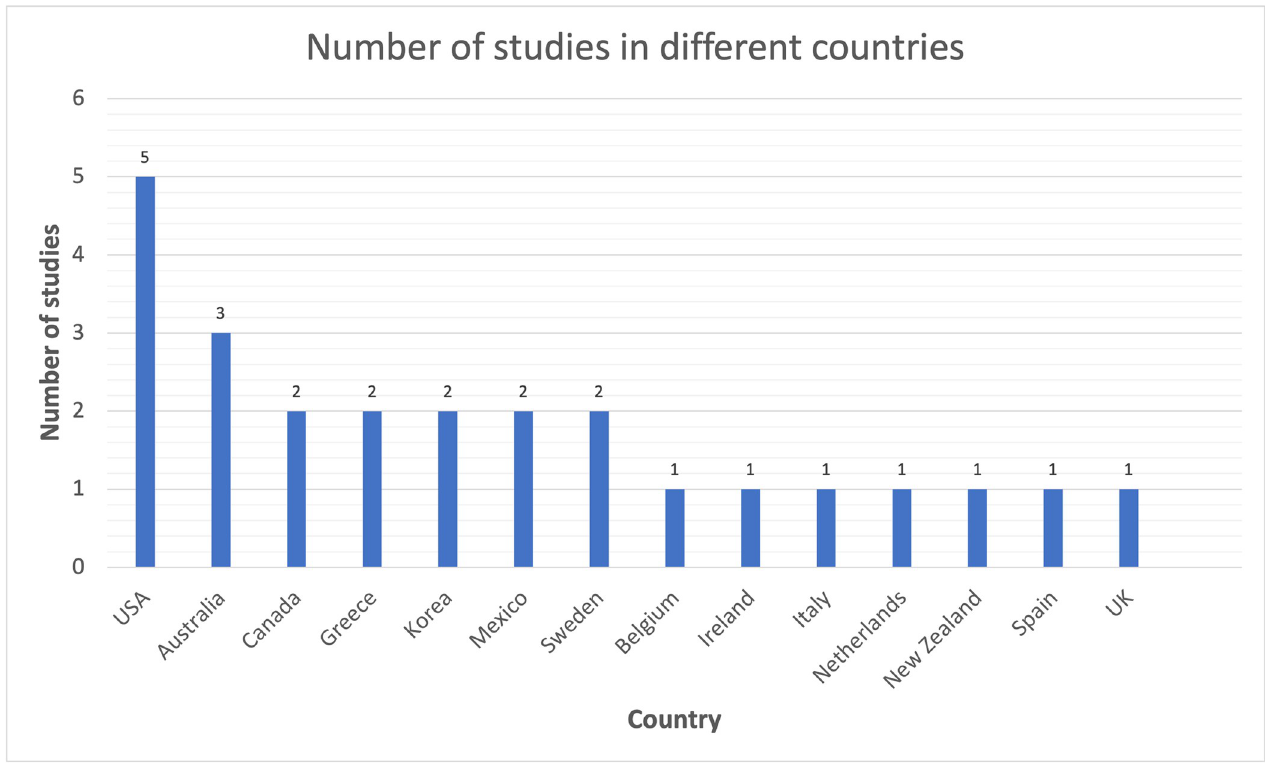
Fig 1. Studies conducted in various